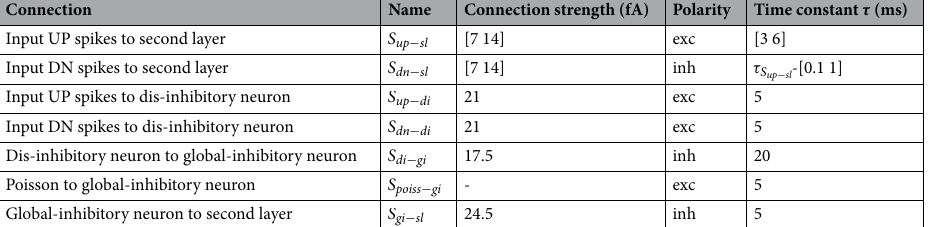
Table 1. Synapse parameters of the SNN detector. A connection between two neurons (Fig. 1d) is characterized by the positive (excitatory, exc) or negative (inhibitory, inh) current in fA and the time constant.